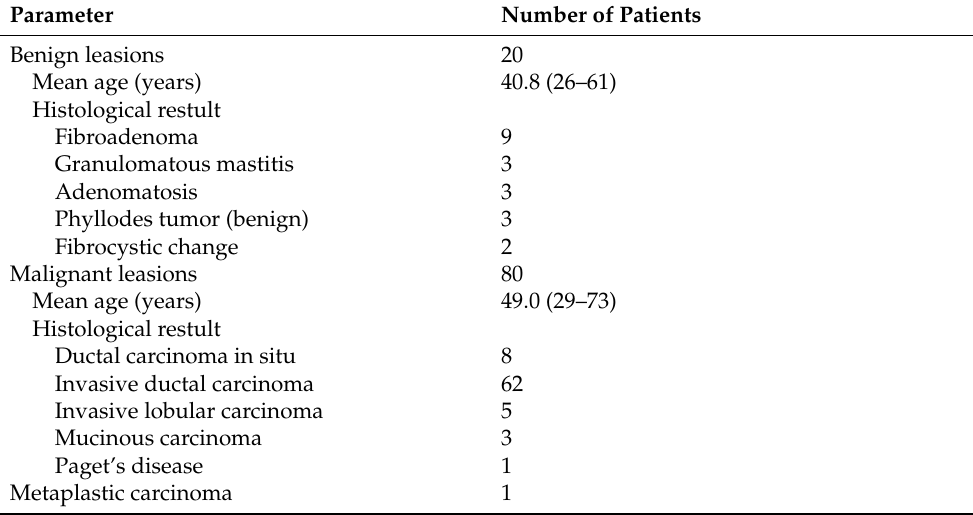
Table 1. Basic clinical information of enrolled patients.